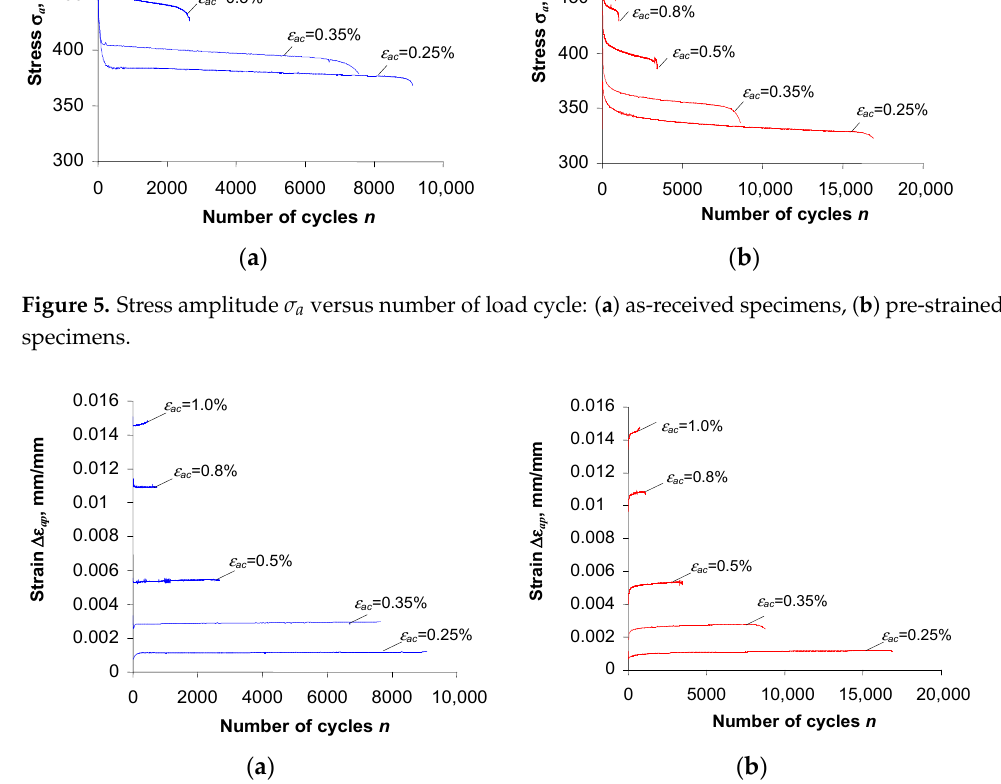
Figure 6. Plastic strain ∆𝜀 (cid:3028)(cid:3043) versus number of cycle: ( a ) as-received specimens, ( b ) pre-strained specimens.